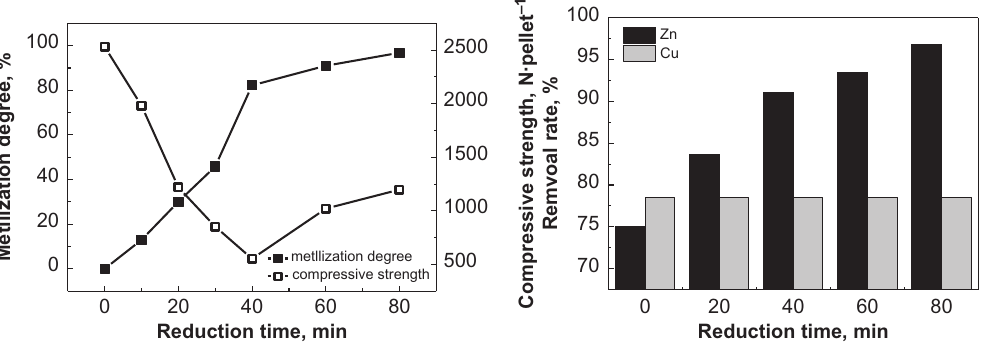
Figure 10: Effect of reduction time on metallization, compressive strength and removal rate of Zn and